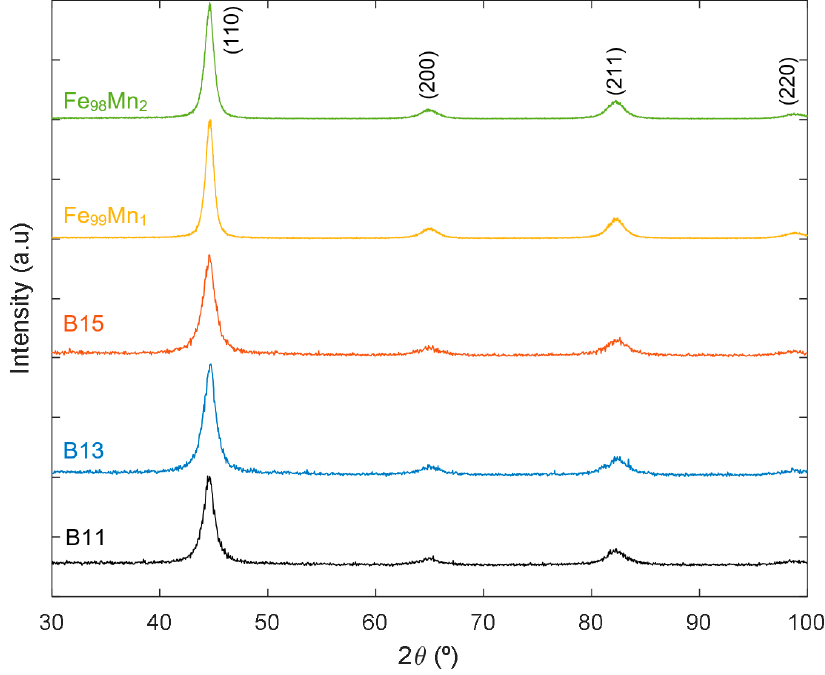
Table 2. Crystallographic parameters and Rietveld refinement results obtained by MAUD.